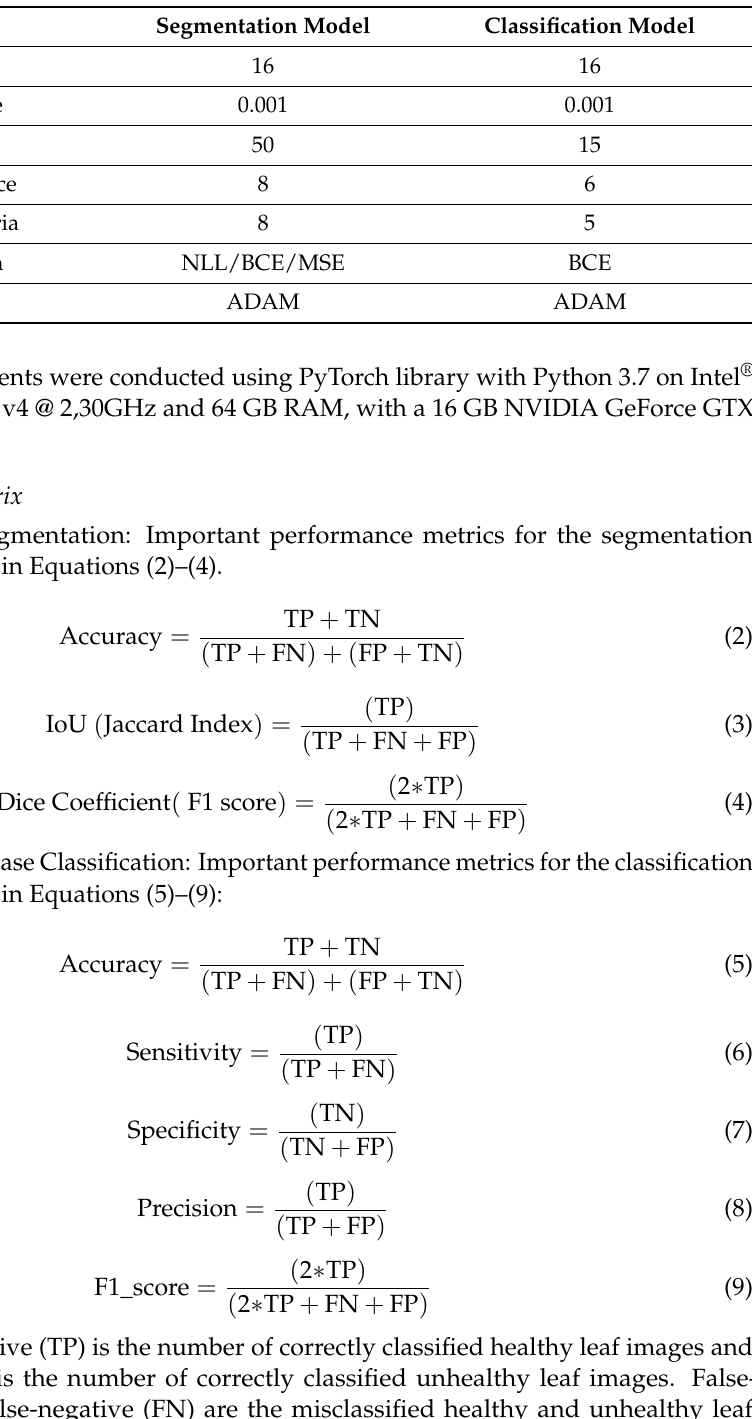
Table 5. Summary of training parameters for segmentation and classification